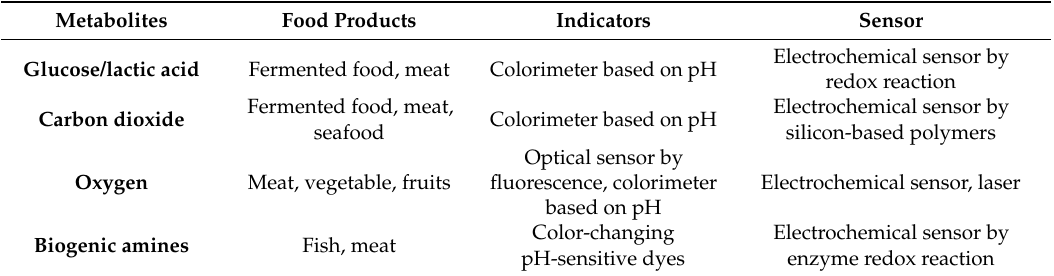
Table 2. Principles of indicators and sensors based on metabolites (based on [36,41,42]).